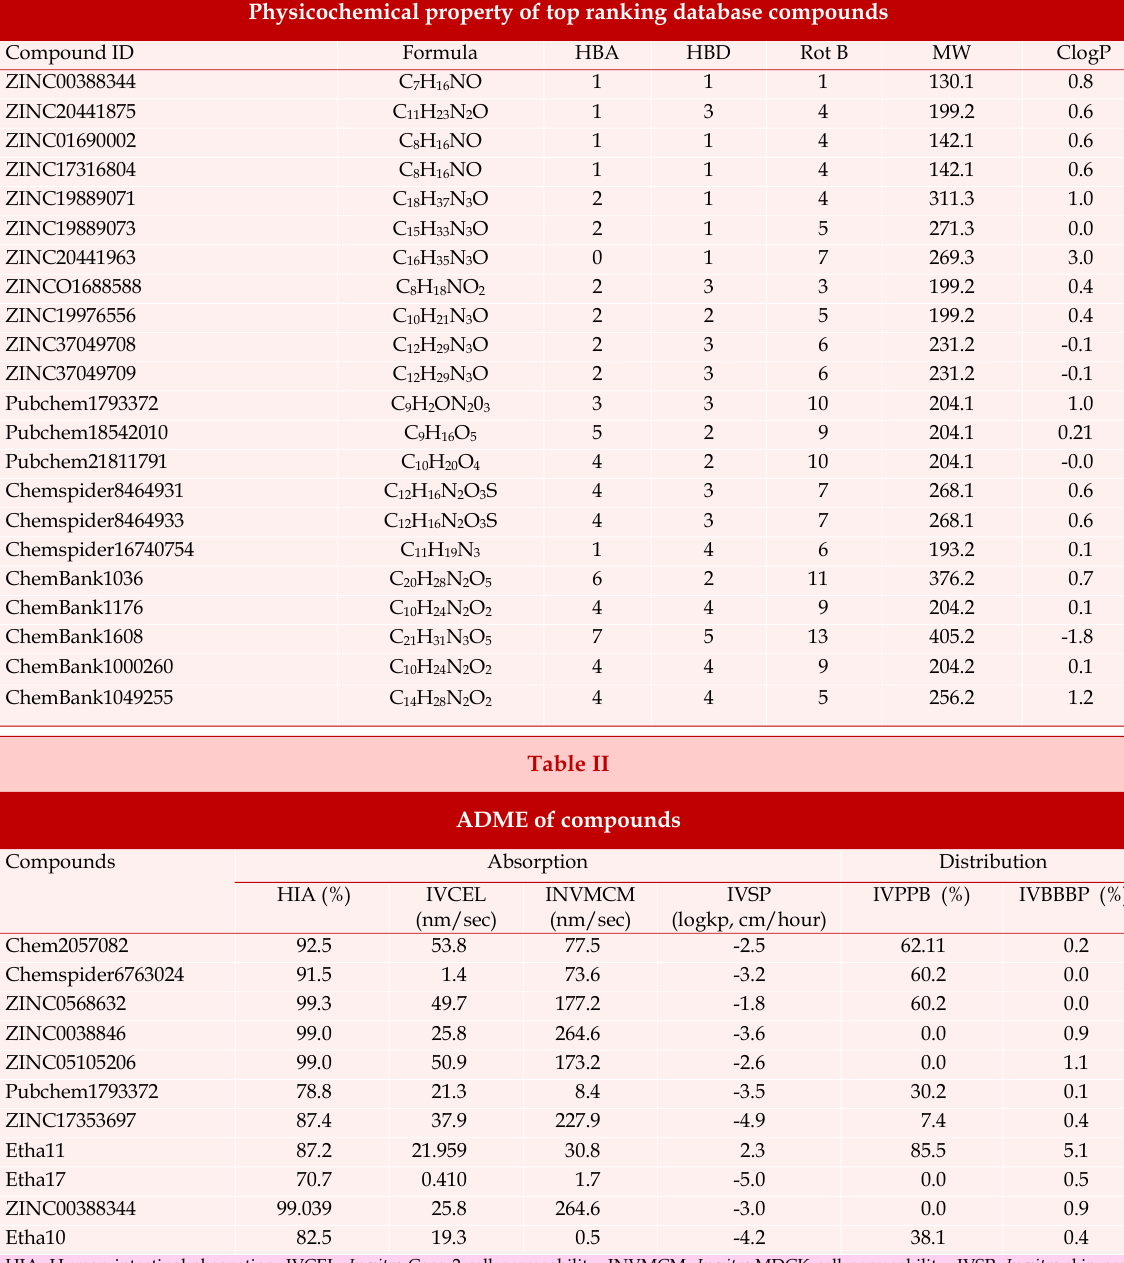
Physicochemical property of top ranking database compounds